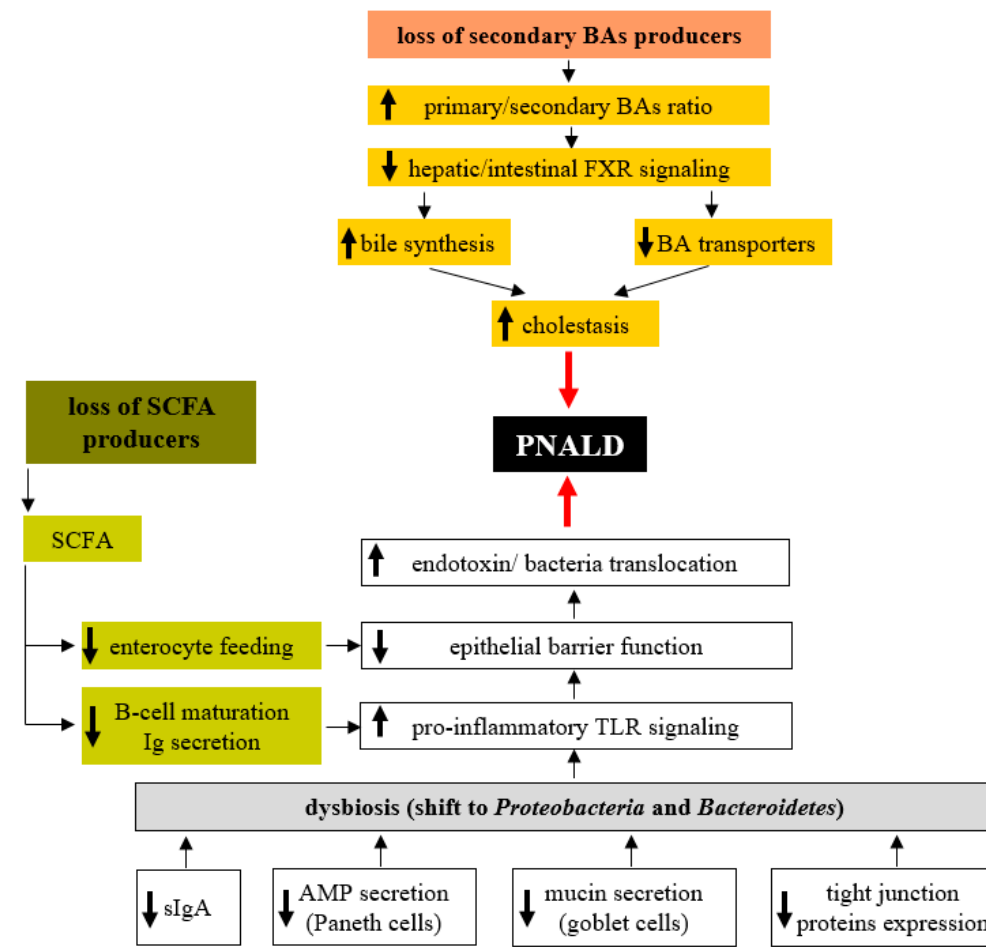
Figure 1. Gut microbiota-related factors contributing to PNALD development. Administration of parenteral nutrition (PN) is associated with decreased production of sIgA, reduced mucin synthesis in goblet cells and impaired antimicrobial function of Paneth cells. All these factors favour the growth of pathogenic bacteria (mostly from Proteobacteria ) at the expense of beneficial commensals. In addition, the reduction in sIgA enables greater microbial access to the host epithelium and triggers an inflammatory response in the lamina propria. Enhanced toll-like receptors (TLR)-signalling due to the increased presence of potential pathogens stimulates the synthesis of pro-inflammatory cytokines in immune cells. Altogether, these factors contribute toward compromised epithelial barrier function (EBF) and increased translocation of endotoxins and even whole bacteria to the portal circulation and the liver, thereby inducing the inflammatory response. The lower abundance of SCFA producers results in decreased short-chain fatty acids (SCFA) availability, which attenuates B-cell maturation, specific antibody production and increased susceptibility to pathogens. The specific loss of secondary bile acids (BA) producers ( Clostridiales ) results in a significant shift towards primary BAs in faeces and impaired hepatic and intestinal farnesoid-X receptor (FXR) signalling. Consequently, bile acid synthesis in the liver becomes upregulated and expression of bile acid transporters becomes downregulated, resulting in the attenuation of BA transport to bile and the development of